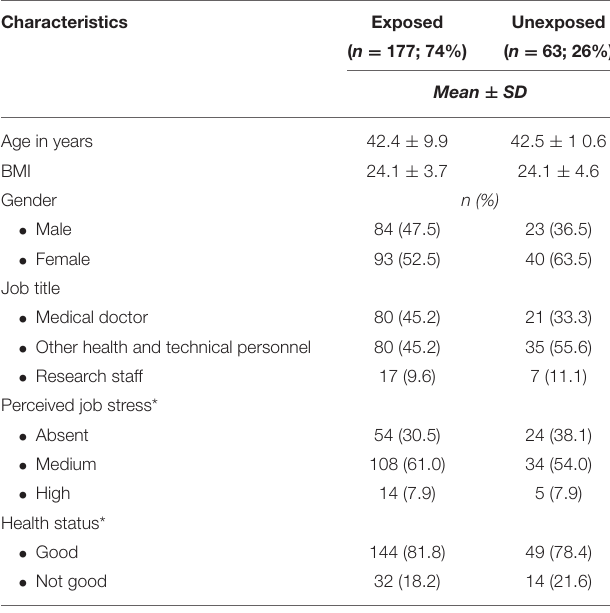
TABLE 1 | Overview of the study population ( n = 240 subjects).